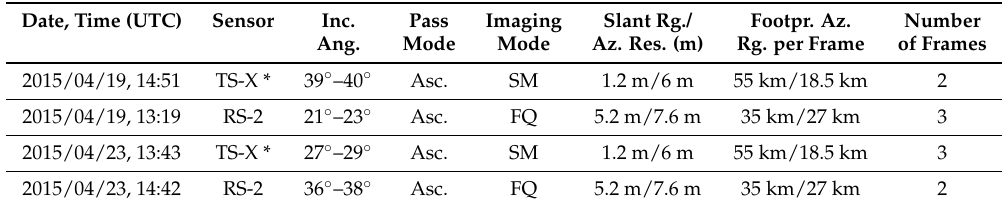
Description of TerraSAR-X (Quadpol) and RADARSAT-2 (Quadpol) images used in this study. * DRA—Dual Receive Antenna (Experimental Mode), SM—StripMap, FQ—FineQuad, Asc.—Ascending